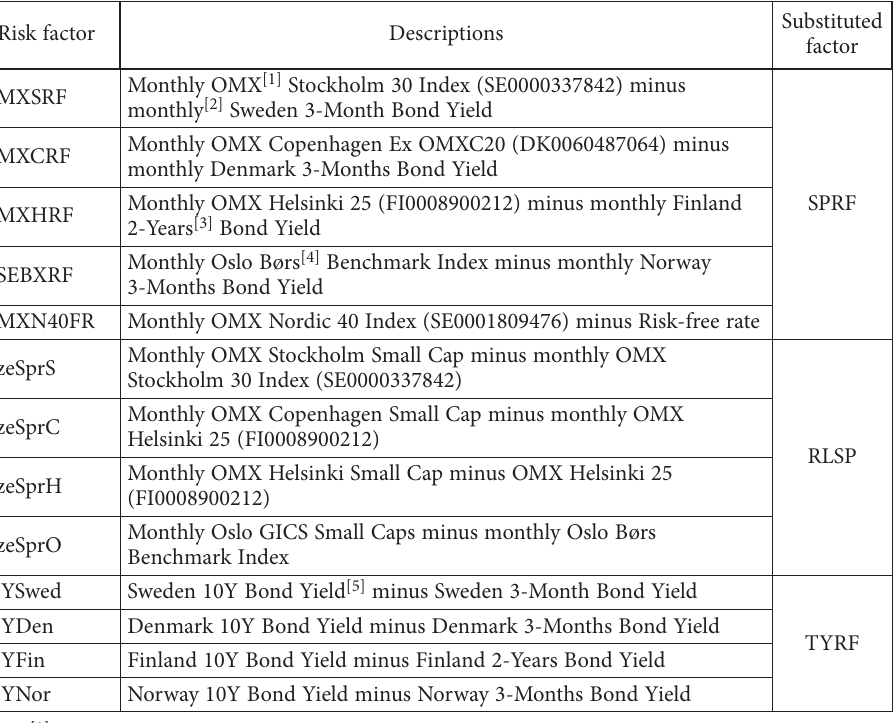
Table 4. Substituted risk